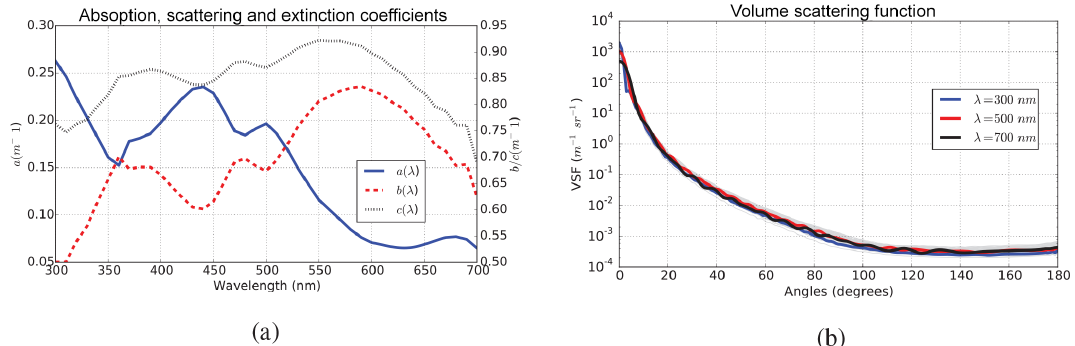
Figure 15. (a) Absorption ( a(λ) ), scattering ( b ), and extinction ( c ) coefficients for cylindrical-shaped particles. (b) Volume scattering function for cylindrical-shaped particles.